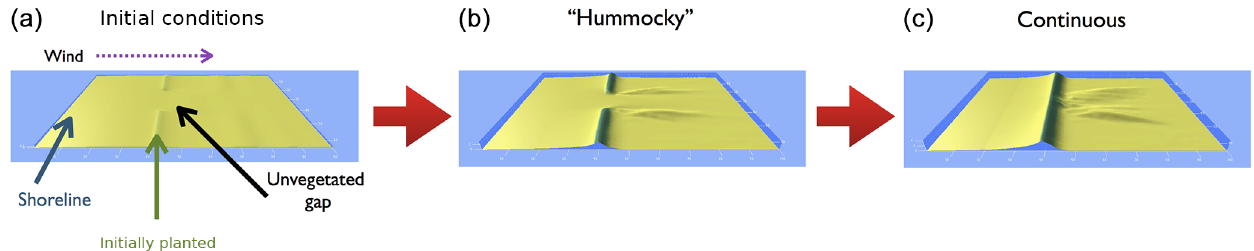
Figure 2. Numerical model definition sketch. (a) Initial conditions. (b) Formation of foredune and the infilling of the initially unvegetated gap. (c) The final continuous foredune ridge at the maximum theoretical dune height.